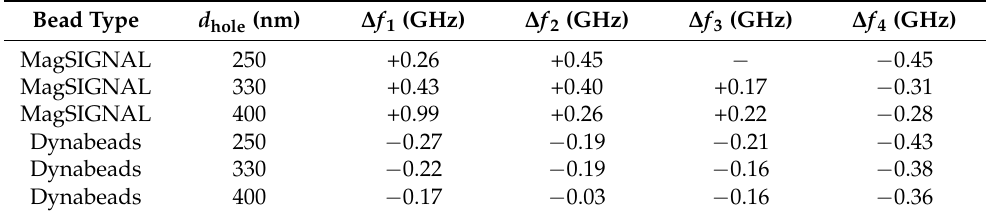
Table 1. Shifts in the FMR frequencies associated with the edge (#1), first extended (#2), second extended (#3), and localized (#4) modes, as a function of the diameter of the antidot array holes and the types of beads to be